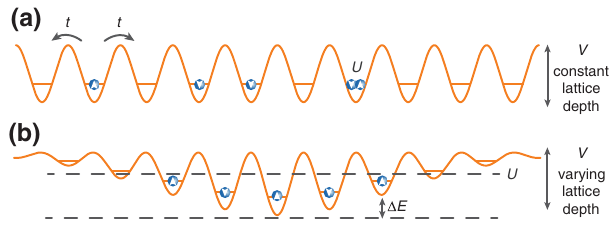
FIG. 10. Fermionic atoms in an optical lattice. (a) Ultracold fermionic atoms trapped in infinitely extended optical lattices of depth V can tunnel between sites at rate t . Two fermions of oppo- site spin on the same site interact with interaction energy U . (b) Finite-sized optical lattices vary quadratically in depth, causing a site-dependent energy offset (cid:8) E , typically referred as harmonic confinement or a lattice